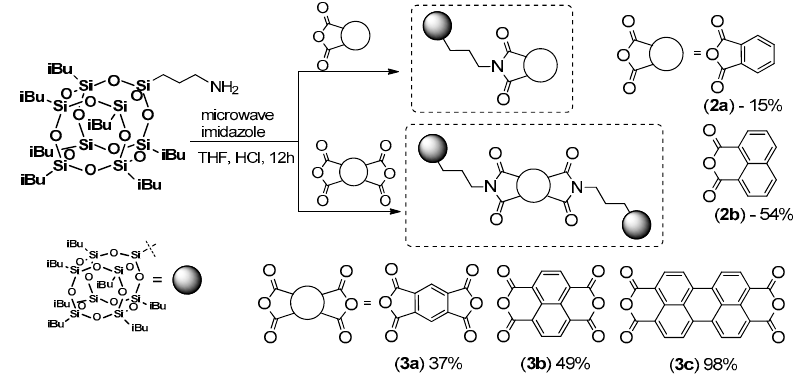
Figure 2. Synthetic path to obtain mono- and di-POSS-based imides and diimides.